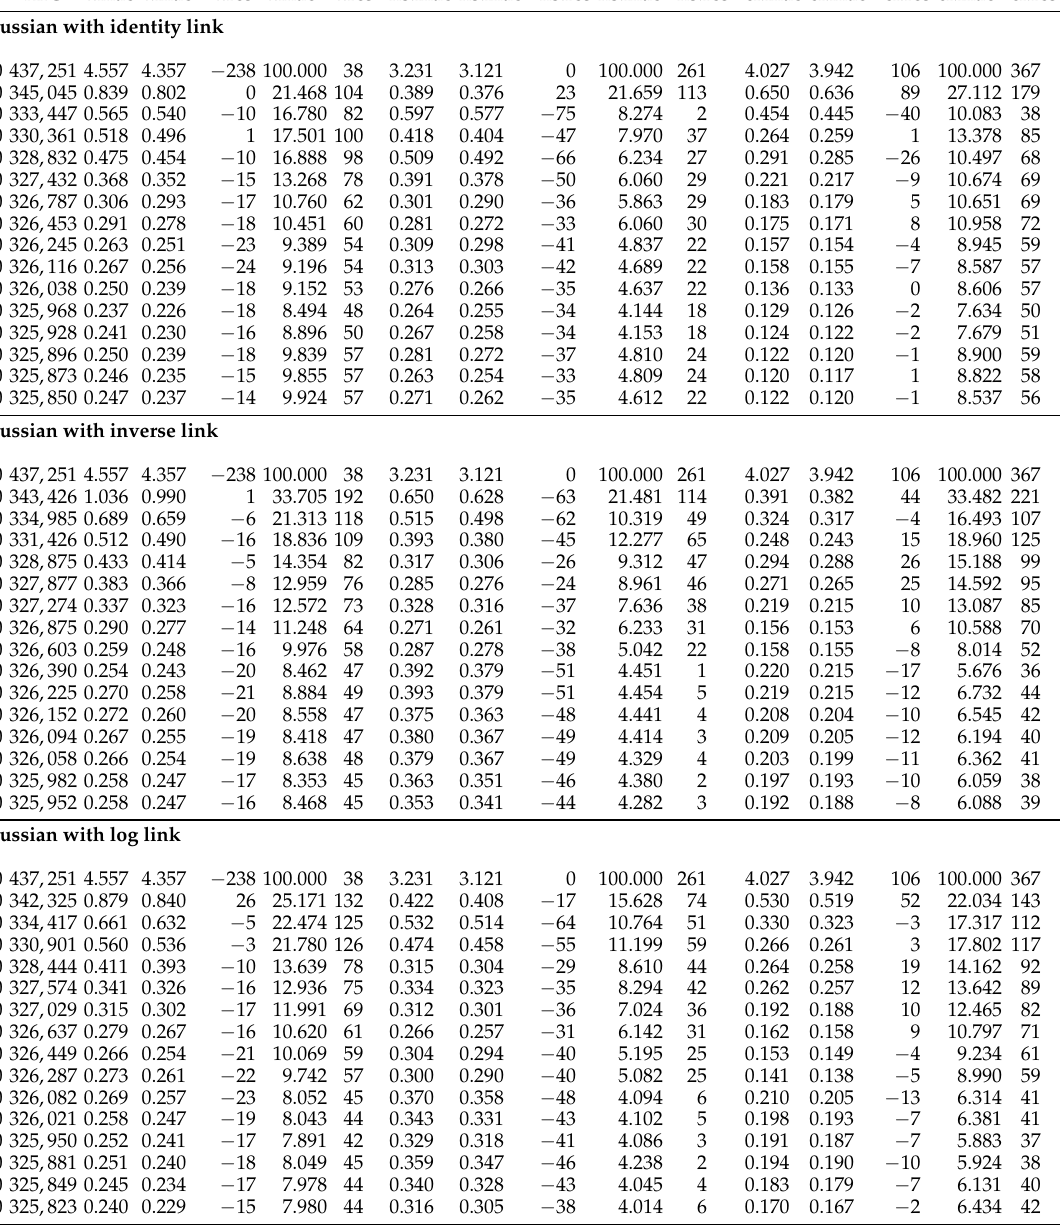
Table A8. AIC scores and out-of-sample validation figures of the gaussian generalized linear models (GLMs) of BEL with identity, inverse and log link functions under 150–443 after each tenth iteration.